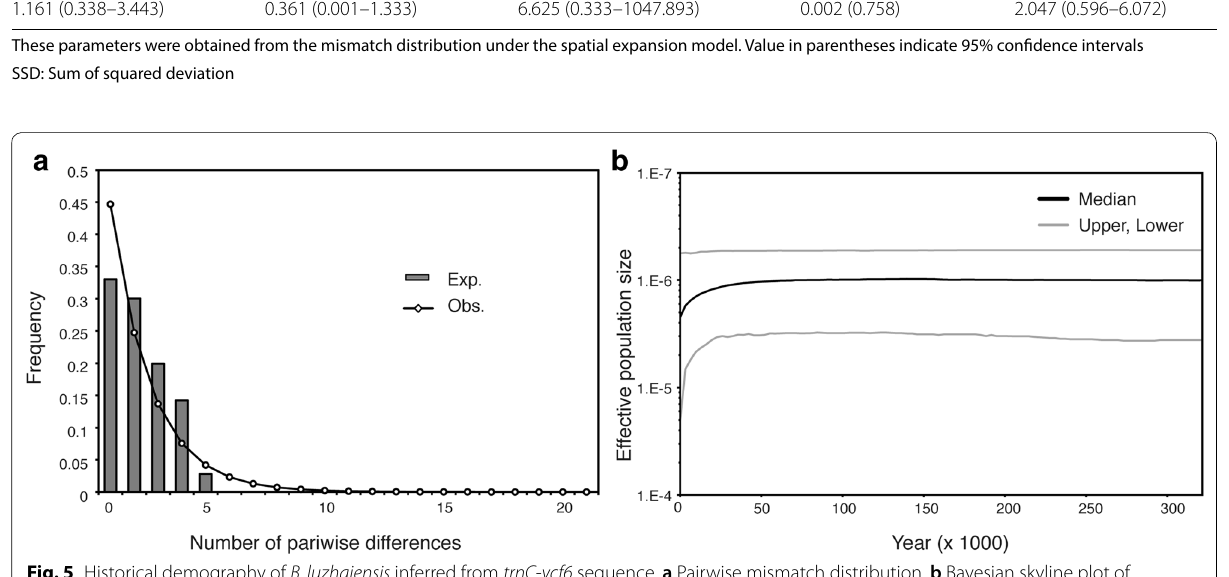
Fig. 5 Historical demography of B. luzhaiensis inferred from trnC ‑ ycf6 sequence. a Pairwise mismatch distribution. b Bayesian skyline plot of structured sampling, showing the median and 95% highest posterior density